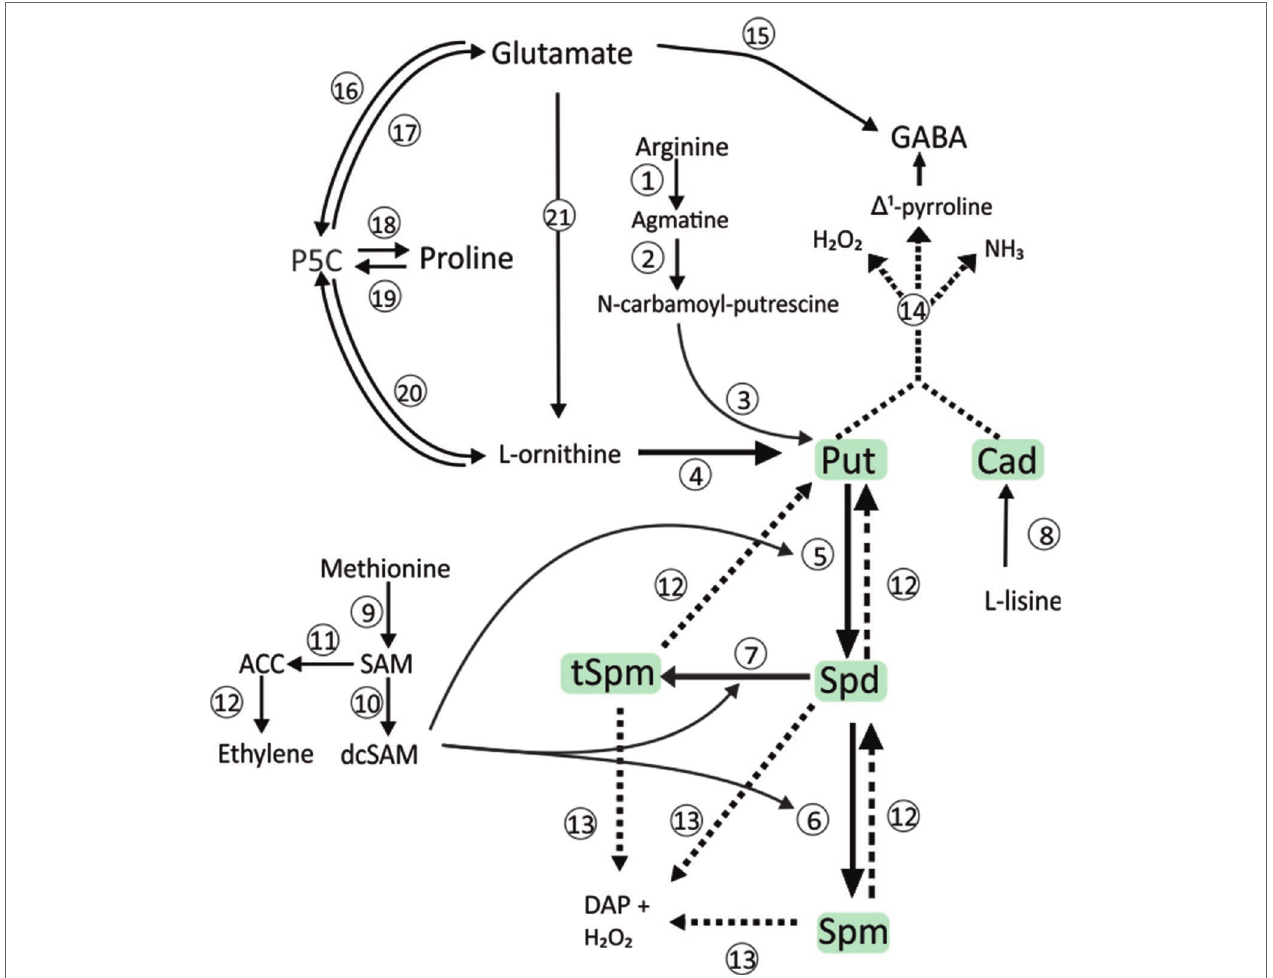
FIGURE 1 | Polyamine metabolism. Biosynthetic pathways for PAs and related metabolites are indicated by continuous lines. Dashed lines show the metabolites from the catabolism of the Pas. Abbreviations: Put, putrescine; Cad, Cadaverine; Spd, spermidine; Spm, spermine; tSpm, thermospermine; SAM, S-adenosylmethionine; dcSAM, decarboxylated S-adenosylmethionine; ACC, aminocyclopropane carboxylic acid; P5C, glutamate-5-semialdehyde. Numbers refer to enzymes: 1, arginine decarboxylase (ADC, EC 4.1.1.19); 2, agmatine iminohydrolase (EC 3.5.3.12); 3, N-carbamoylputrescine amido-hydrolase (EC 3.5.1.53); 4, ornithine decarboxylase (ODC, EC 4.1.1.17); 5, spermidine synthase (SPDS, EC 2.5.1.16); 6, spermine synthase (SPMS, EC 2.5.1.22); 7, thermospermine synthase; 8, L-lysine decarboxylase (EC 4.1.1.18); 9, SAM synthetase; 10, SAM decarboxylase (SAMDC, EC 4.1.1.50); 11, ACC synthase (EC 4.4.1.14); 12, ACC